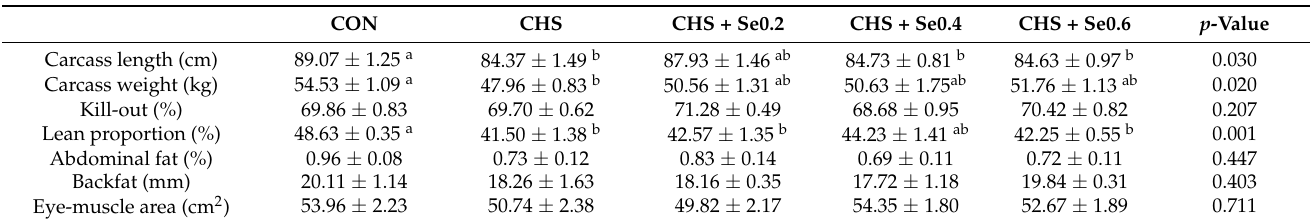
Table 3. Effects of CHS and OH-SeMet supplementation on carcass traits of growing pigs.